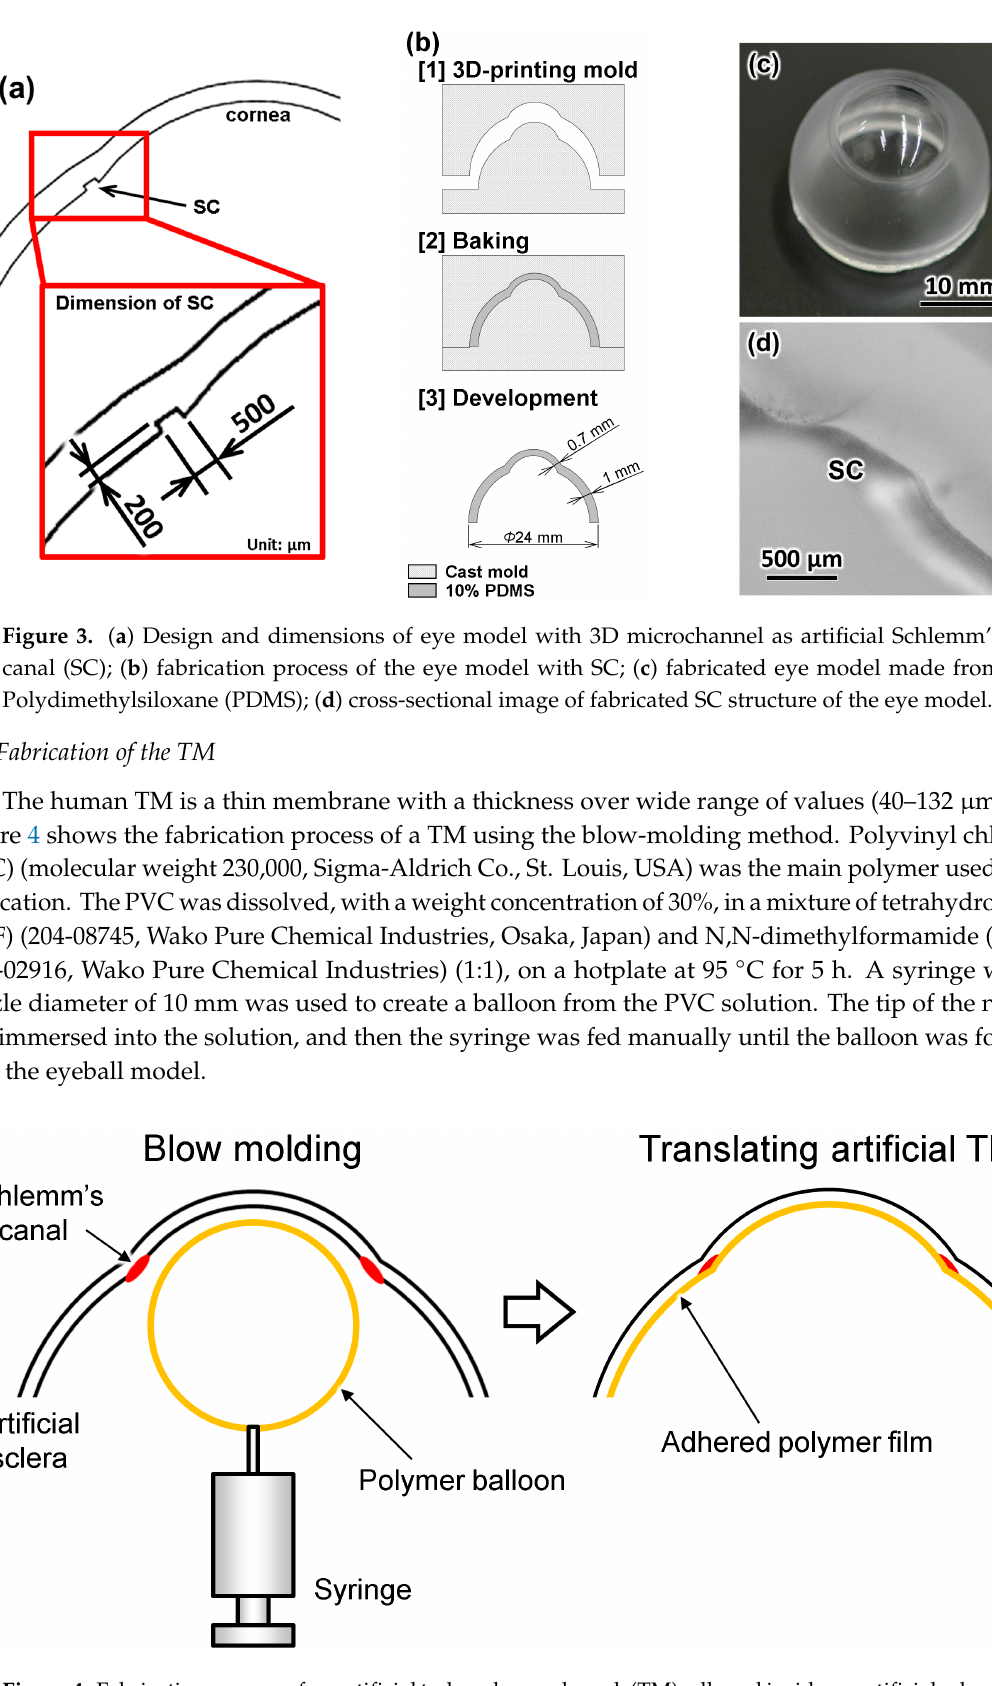
Figure 4. Fabrication process of an artificial trabecular meshwork (TM) adhered inside an artificial sclera.